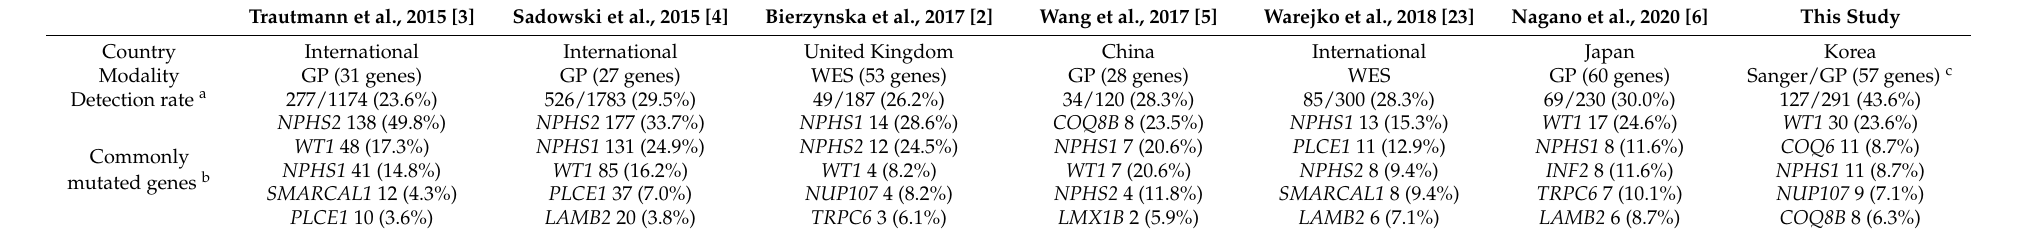
Table 3. Genetic studies in large cohorts of pediatric patients with steroid-resistant nephrotic syndrome.